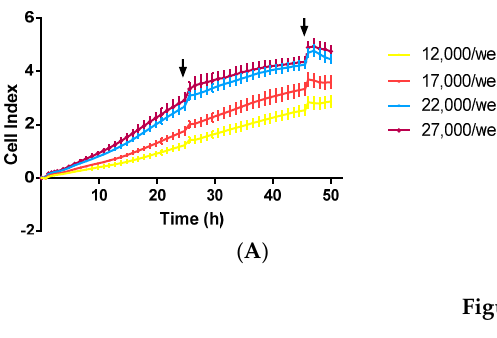
Figure 1. Cont. Figure 1.